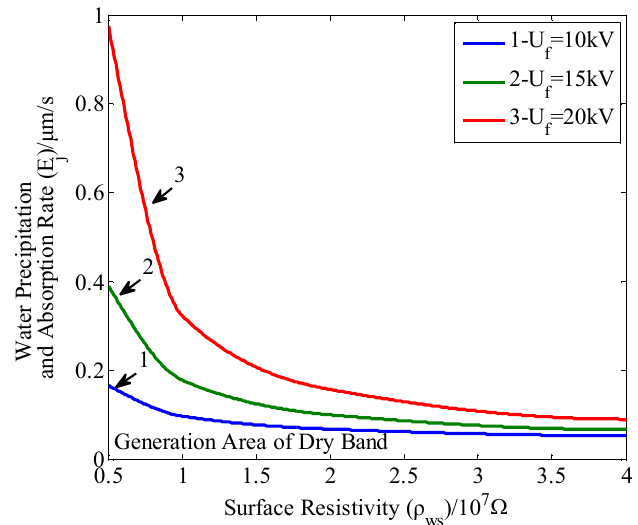
Figure 6. Conditions for the generation of dry bands.